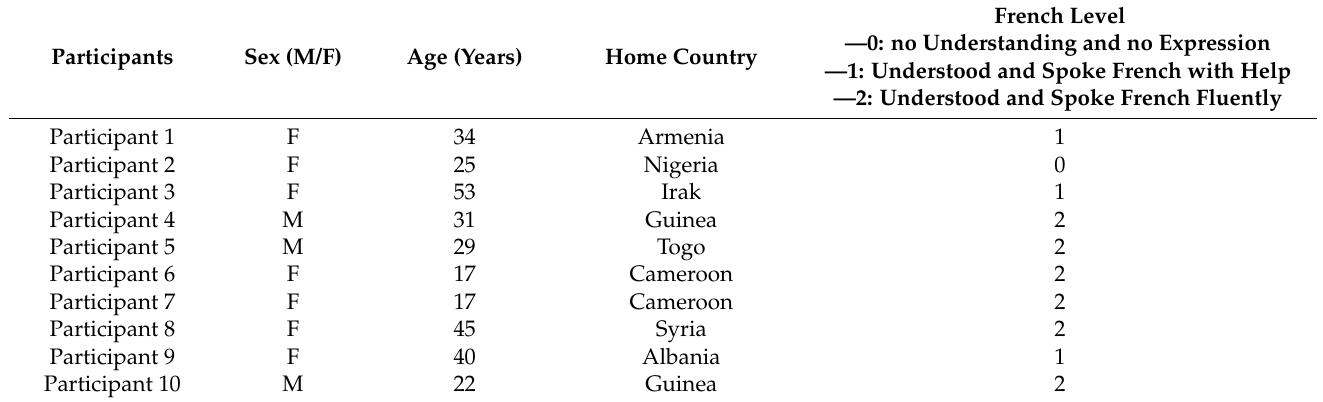
Table 1. Demographic characteristics of the included